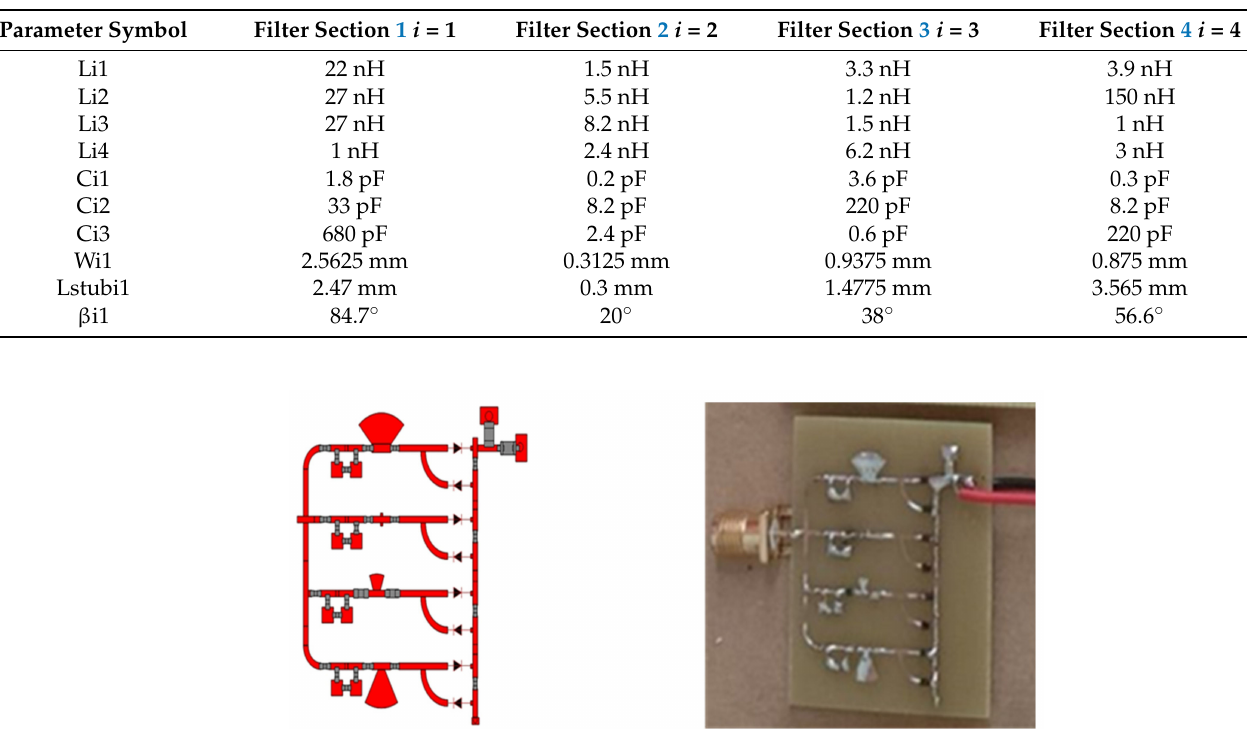
Table 3. Optimized value of all components for proposed rectifier topology.